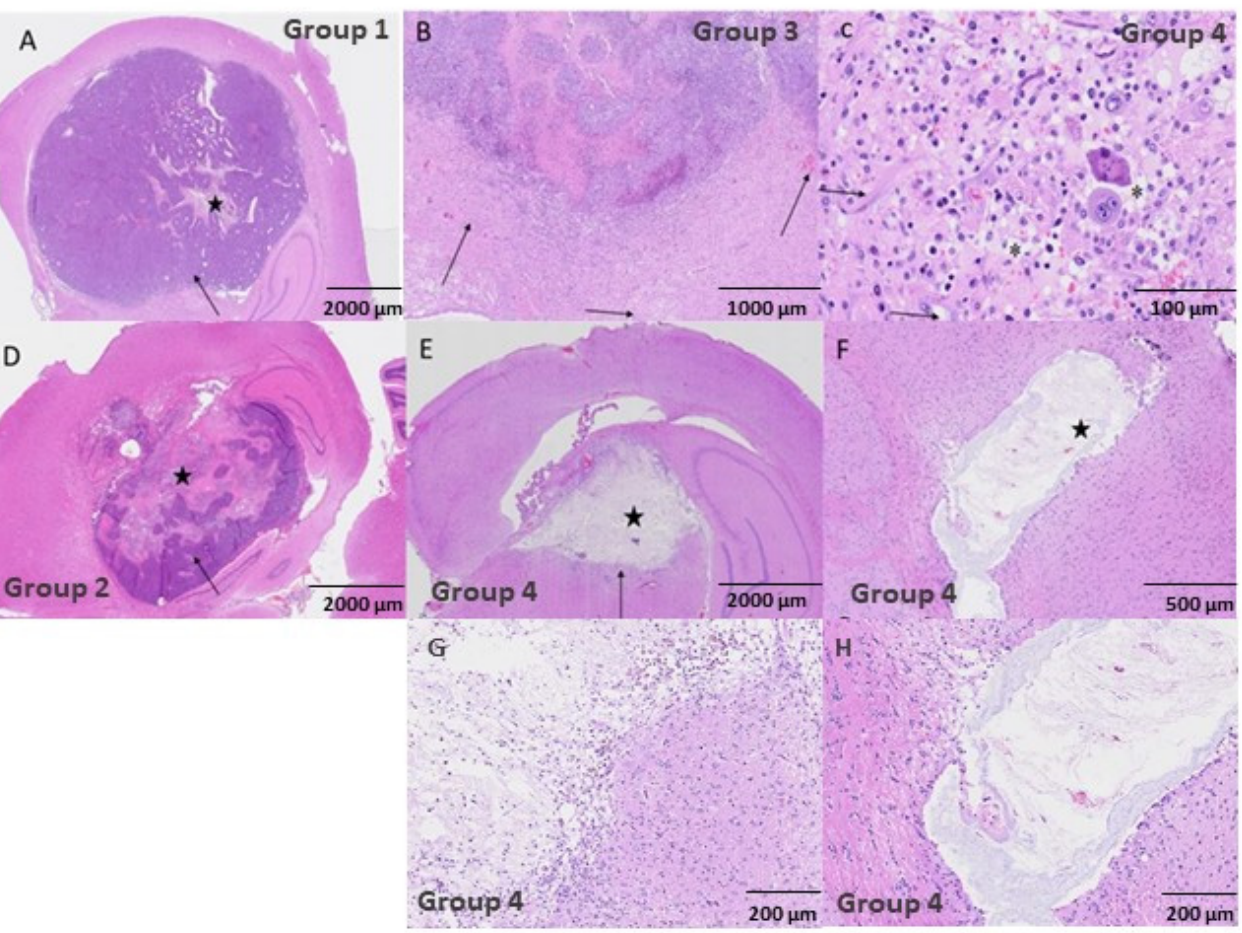
Figure 5. HE stained histopathology images. ( A ) corresponds to the non-irradiated control group with a scale bar of 2000 µ m. There is a large glioma tumor (arrow) with a small necrotic area of necrosis and inflammation in the center (star). ( B – D ) depict the group 3 animals with scale bars of 1000 µ m and 100 µ m, respectively. In ( B ) there is marked inflammation around the tumor, with mild edema and hemorrhage indicated by the arrows. In ( C ) we observe peritumoral mixed inflammation with macrophages, lymphocytes, plasma cells, and neutrophils. The neuroparenchyma was expanded by edema and sites of spongiosis are depicted by the asterisks. Glial cells were reactive (arrows). The group 2 animals are shown in ( D ) with a scale bar of 2000 µ m. There are glioma tumoral cells (arrow) with a large central area of necrosis (star). ( E , F ) are for group 4 animals with scales of 2000 µ m and 5000 µ m, respectively. In ( E ) we observe a central pseudo-cystic area of old necrosis (star) surrounded by inflammation (arrow). Panel F depicts a center of necrosis with only pale eosinophilic substance and necrotic cell debris (star), with minimal inflammatory peripheral infiltrate. ( G , H ) correspond to amplified images of the areas of interest in images ( E , F ),